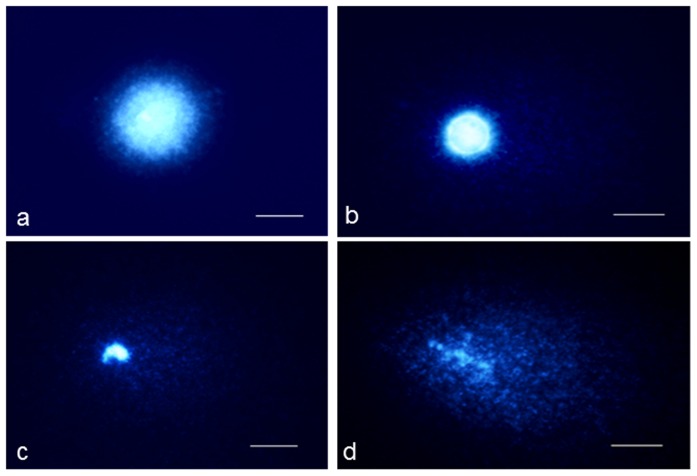
Comet assay in C. capillaris cells.a – control nuclei, not damaged; b, c, d – cells treated with a 2 mM MH, nuclei with different levels of DNA damage. Bars represent 5 µm.